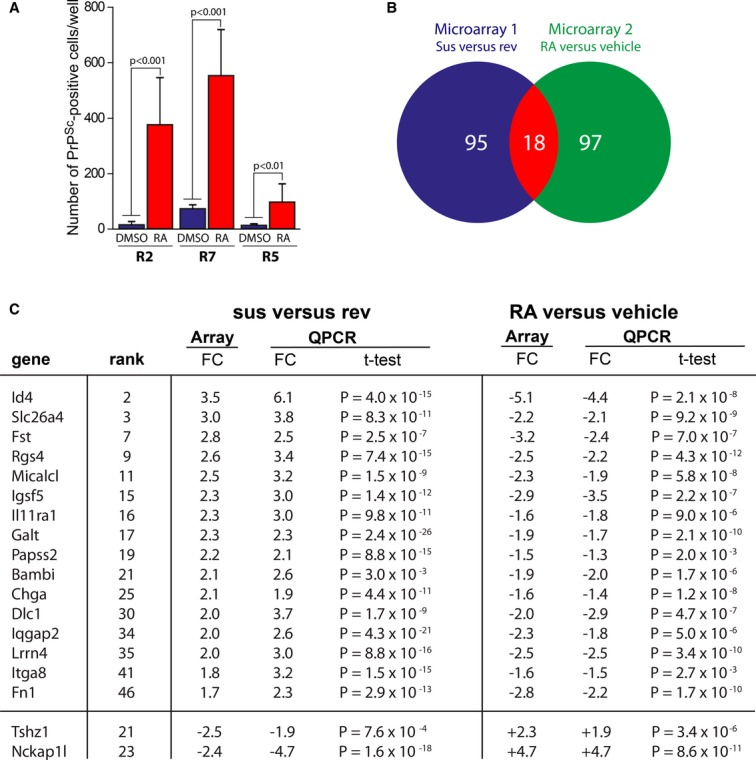
Identification of genes associated with a gain of prion susceptibilityIncreased susceptibilities of revertant cell clones R2, R5 and R7 after retinoic acid (RA) treatment, replotted from Supplementary Table S4 for clarity.A Venn diagram shows the relation between gene candidates derived from two independent microarray studies. The number of genes differentially expressed between susceptible and revertant clones (sus versus rev, Microarray 1) and revertant R7 cells in absence and presence of RA (RA versus vehicle, Microarray 2) is shown. The intersection in red represents 18 genes that are common to both gene candidate lists.Gene expression values of 18 putative prion susceptibility genes are shown. Fold expression changes (FC) of differentially expressed genes between susceptible and revertant cells and between mock- and RA-treated revertant R7 cells are shown for microarray (FDR < 0.01) and qPCR analysis, respectively, and ranked according to their FC values on microarray. The statistical significance of gene expression differences by qPCR are presented as discrete P-values (Student's t-test). Genes expressed in revertant and susceptible cells are represented as positive and negative FC values, respectively. Genes downregulated and upregulated upon RA treatment are presented as negative and positive FC values, respectively.